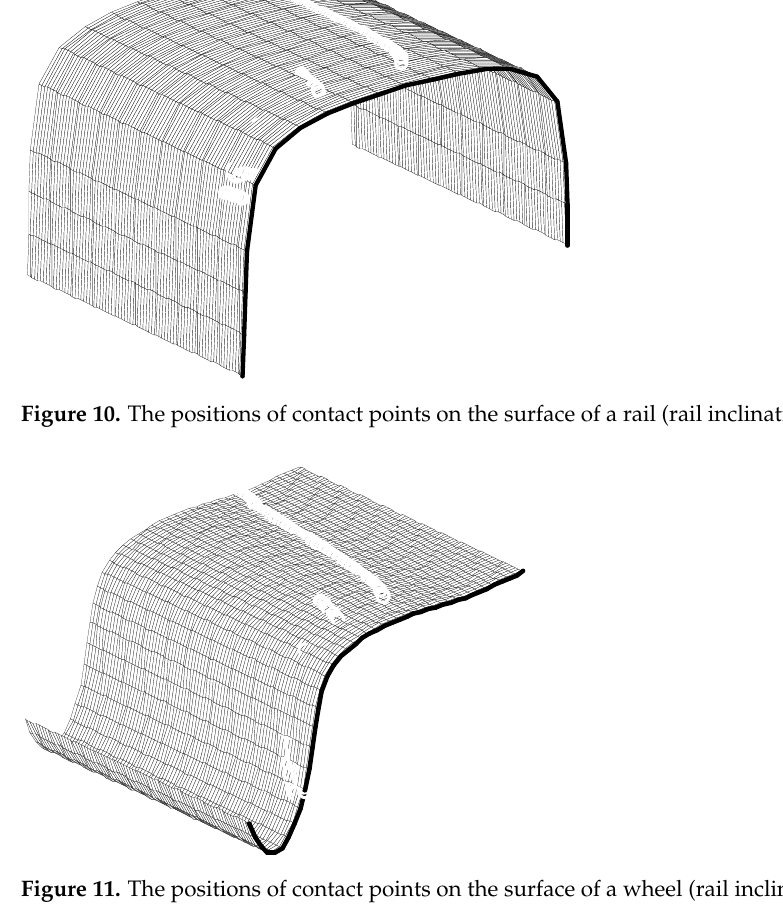
Figure 11. The positions of contact points on the surface of a wheel (rail inclination 1:20).